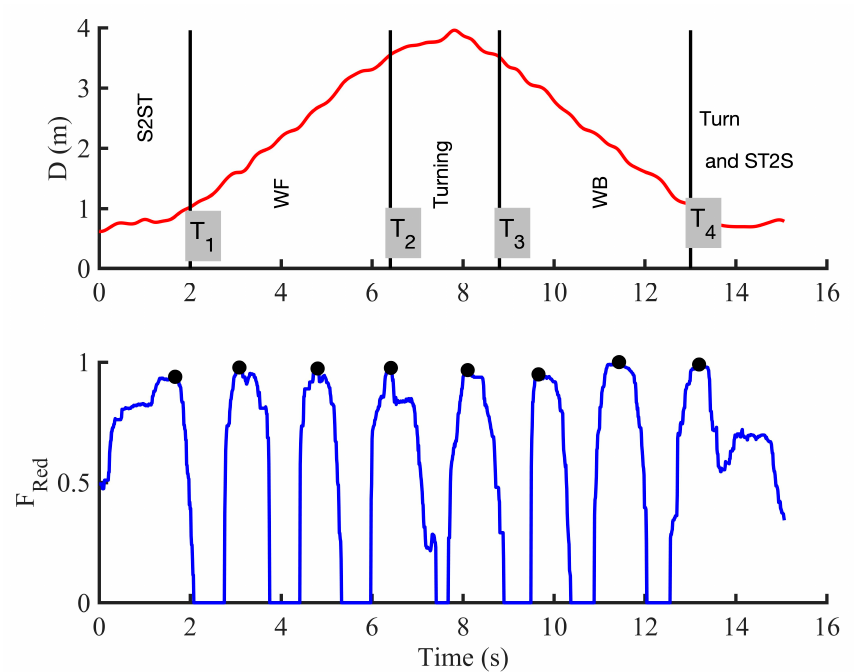
Figure 9. Proposed system showing the segmentation of the TUG test in different activities using the radar and the instrumented insole. The walking phase in this test was segmented in different strides using only two FSRs. (S2ST: sit-to-stand; WF: walk forward; WB: walk back; ST2S: stand-to-sit; D: distance measured by the radar antenna; F red : use of two FSRs from the reduction process).